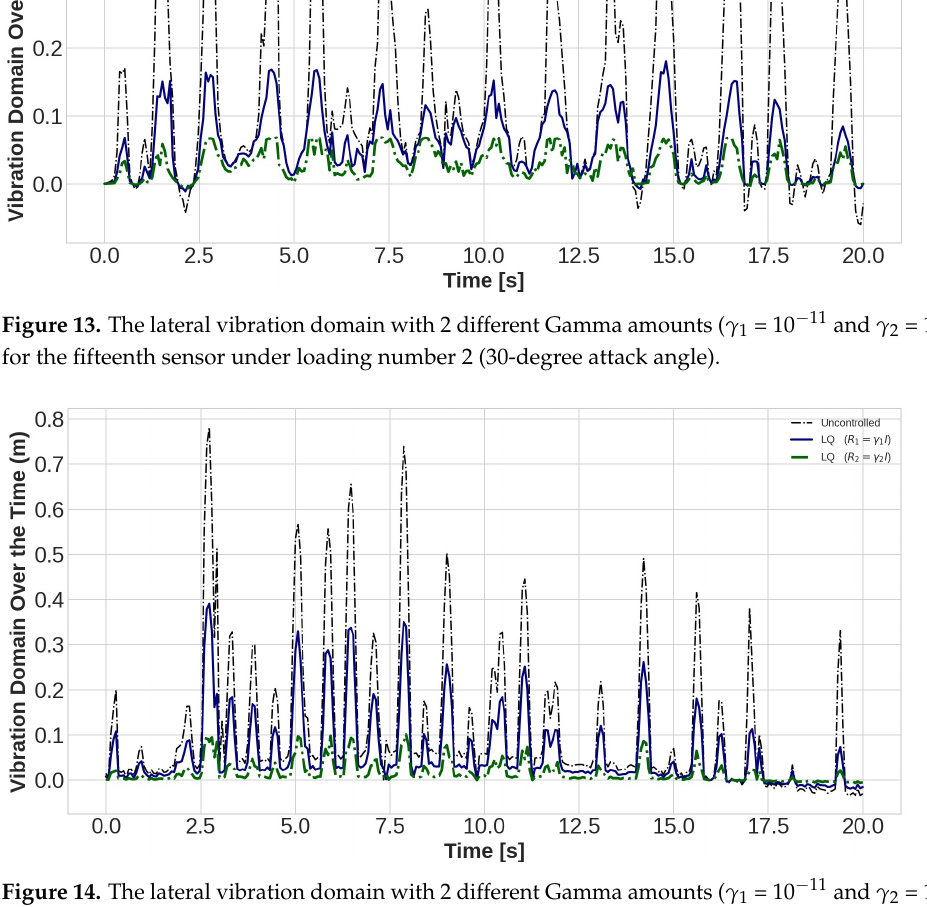
Figure 14. The lateral vibration domain with 2 different Gamma amounts ( γ 1 = 10 − 11 and γ 2 = 10 − 13 ) for the thirtieth sensor under loading number 2 (30-degree attack angle).